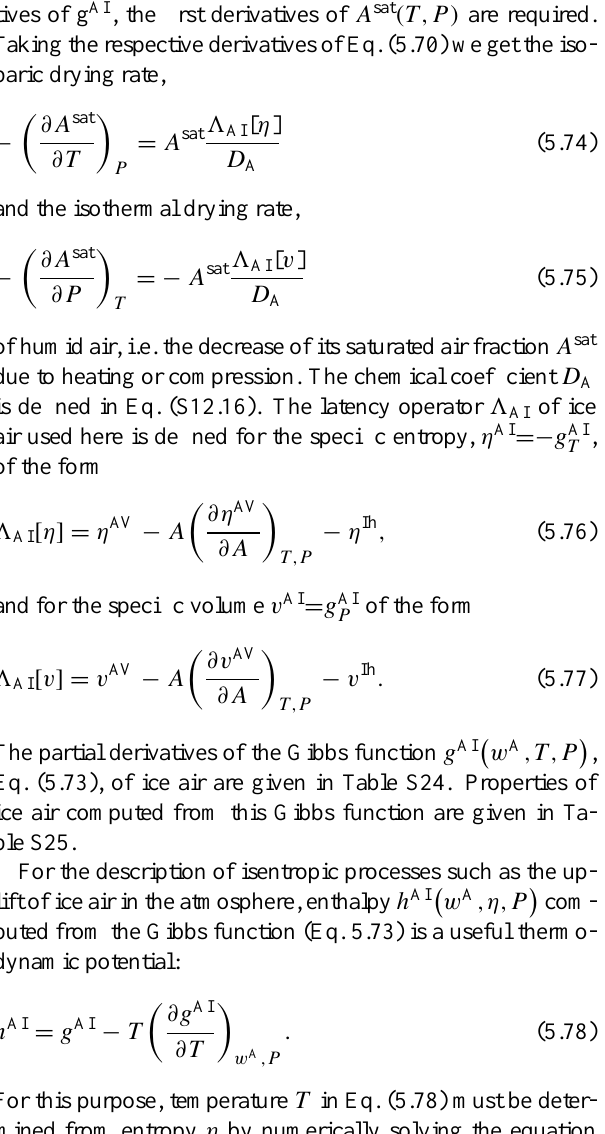
Table S25. For the computation of the partial T − P deriva- tives of g AI , the first derivatives of A sat (T,P) are required. Taking the respective derivatives of Eq. (5.70) we get the iso- baric drying